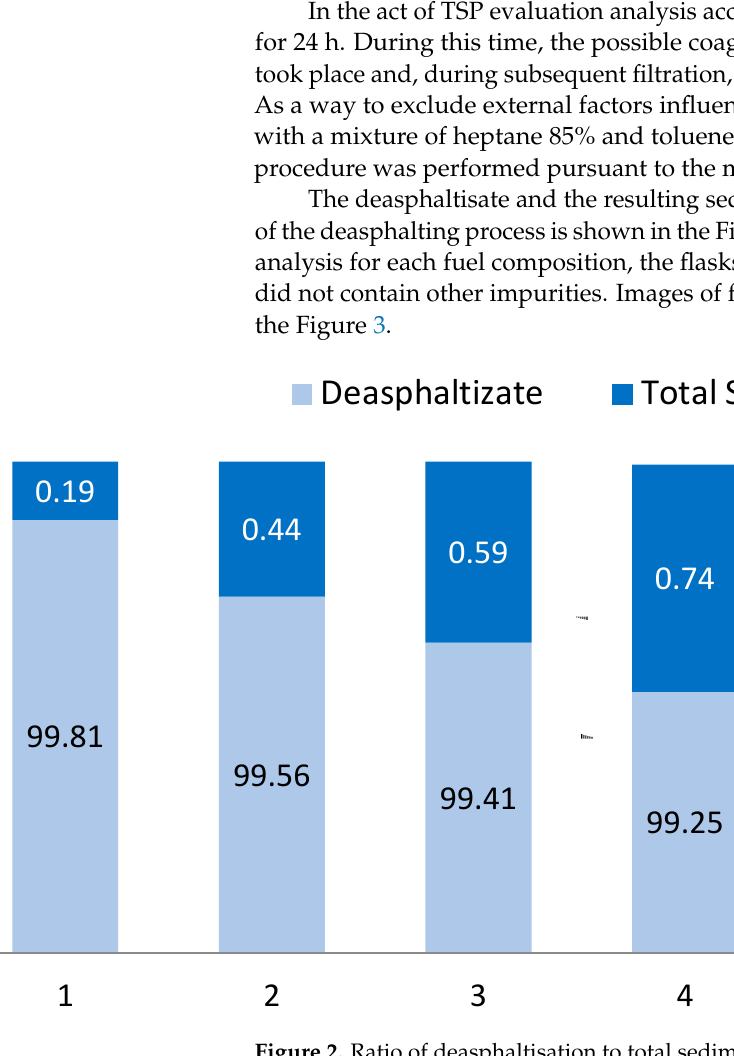
Figure 2. Ratio of deasphaltisation to total sediments.